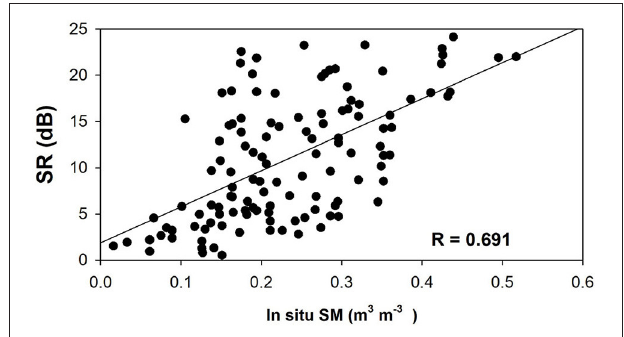
FIGURE 4 | Comparisons of SR and in situ